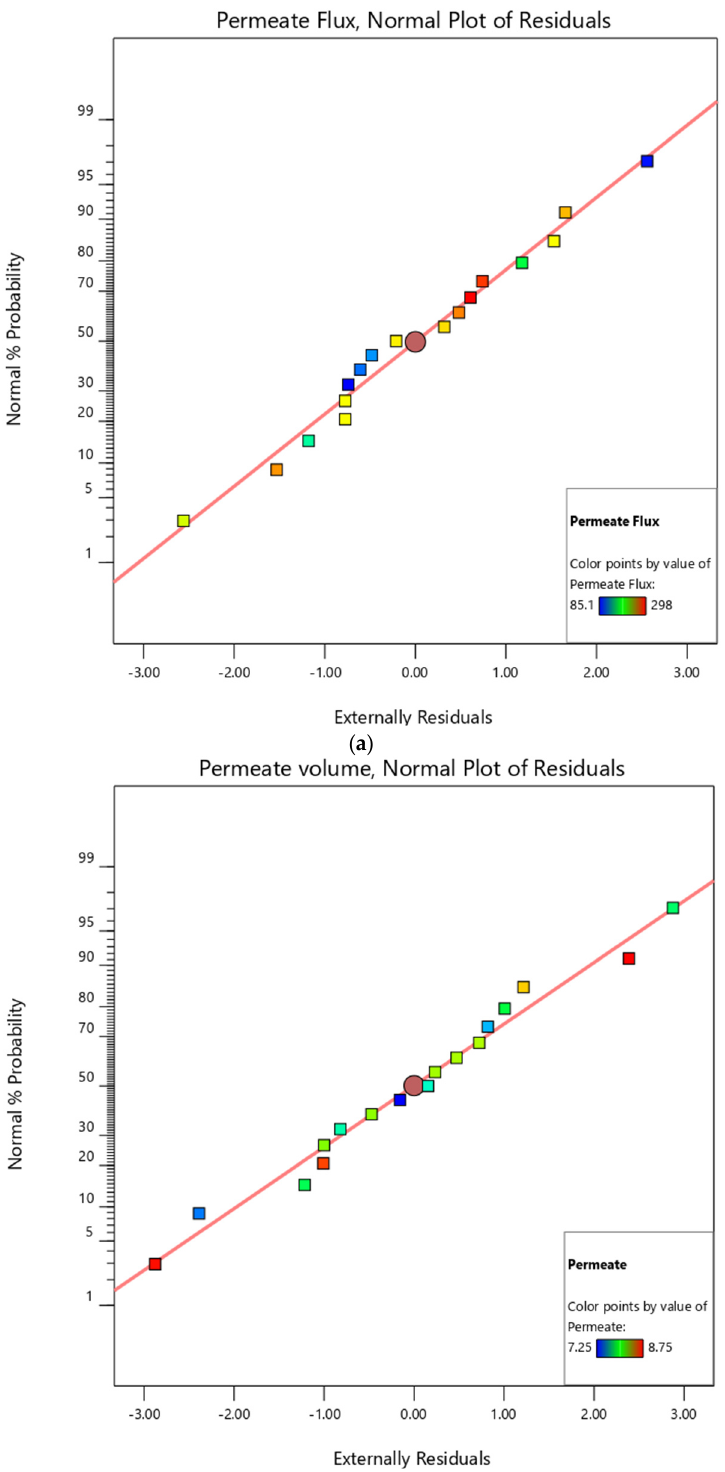
Figure 3. Diagnostic normal probability plots of residuals for ( a ) permeate flux, and ( b ) membrane permeate